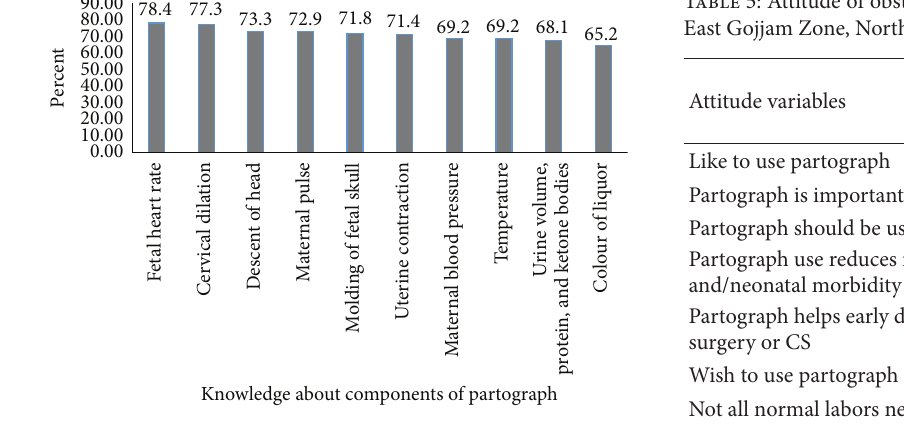
Figure 1: Obstetric caregivers knowledge about components of partograph, East Gojjam Zone, Northwest Ethiopia, 2015 ( 𝑛 = 273 ).